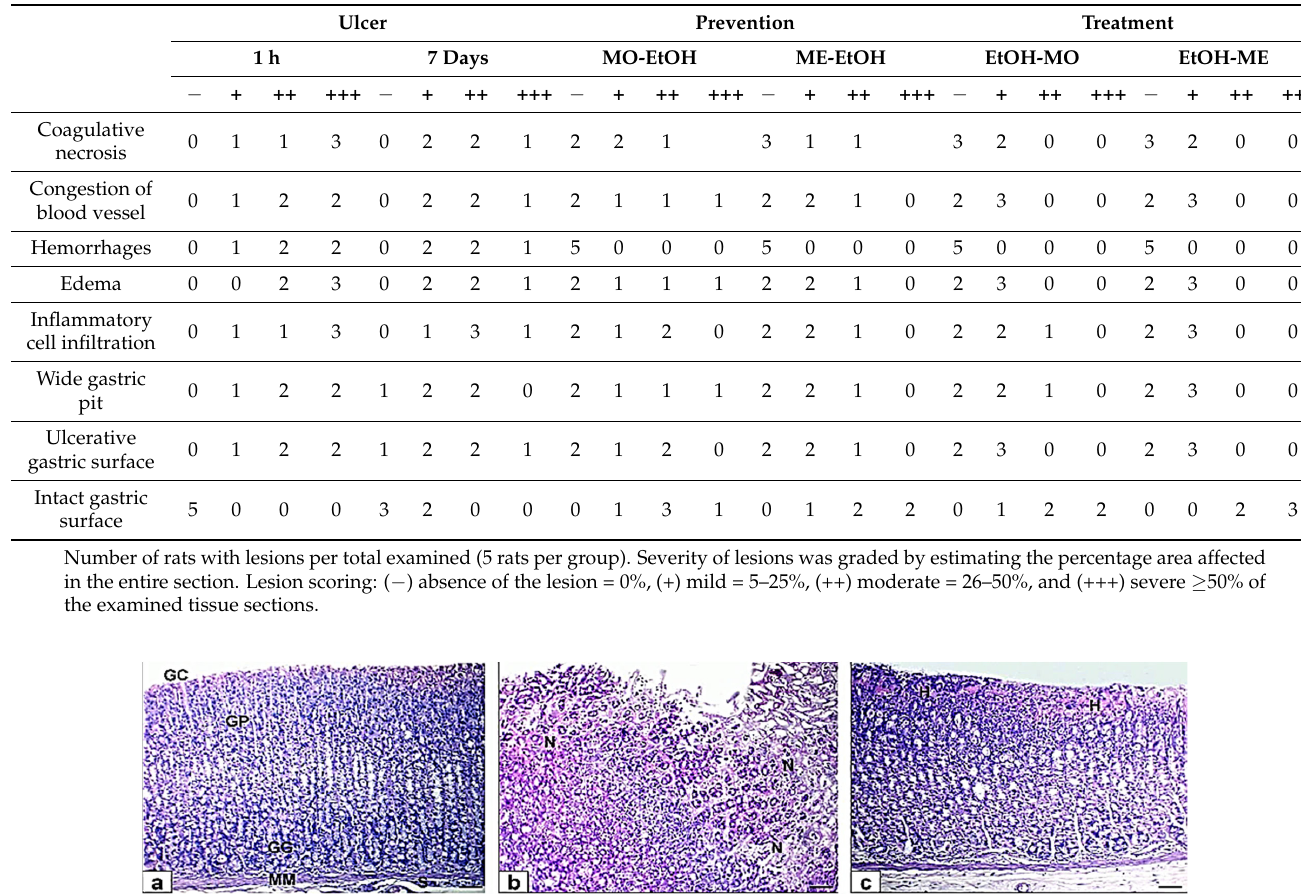
Table 4. Incidence and severity of histopathological lesions in the experimental groups.